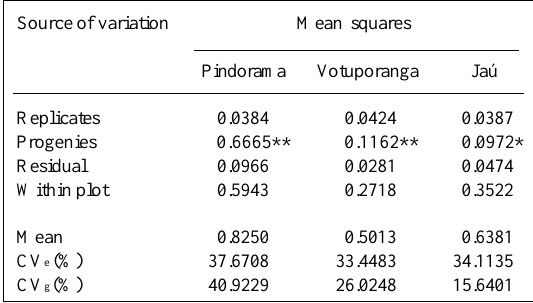
1 The degrees of freedom for repetition, progenies and residual were 4, 21 and 84, respectively. *P < 0.05, **P<